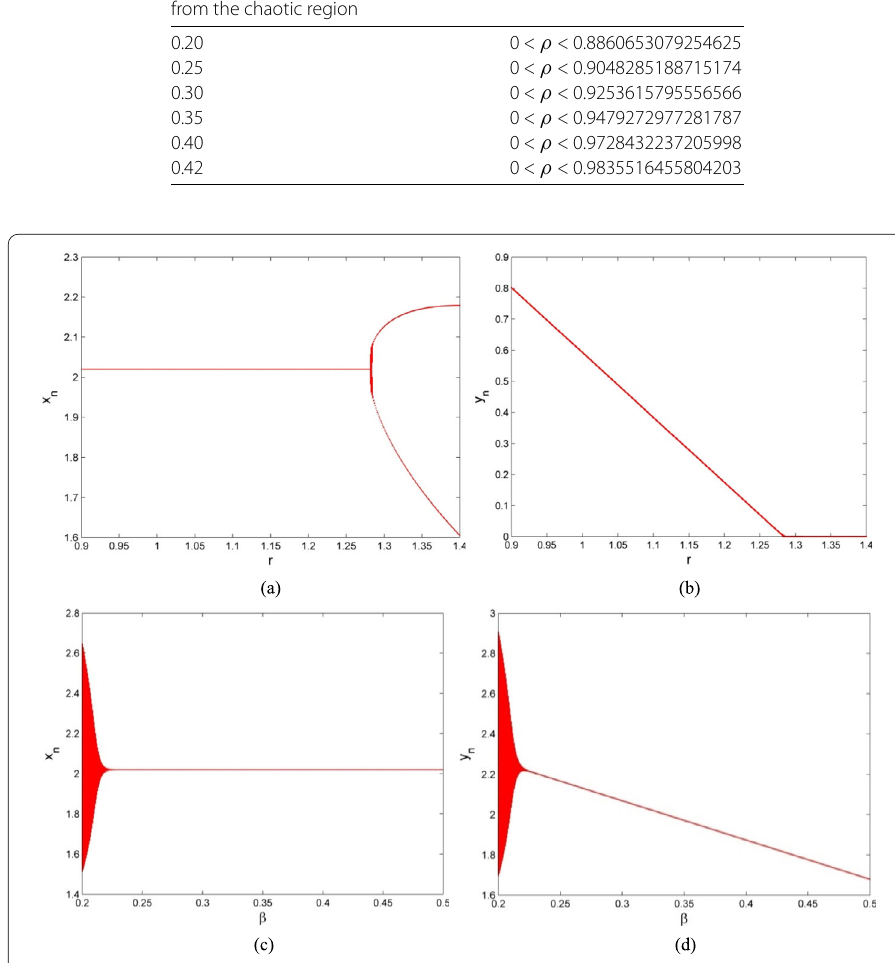
Figure 4 Bifurcation diagrams for controlled systems (35) and (38). ( a ) Bifurcation diagrams of prey for controlled system (35) when ρ = 0.77. ( b ) Bifurcation diagrams of predator for controlled system (35) when ρ = 0.77. ( c ) Bifurcation diagrams of prey for controlled system (38) when ρ = 0.8860653. ( d ) Bifurcation diagrams of predator for controlled system (38) when ρ = 0.8860653